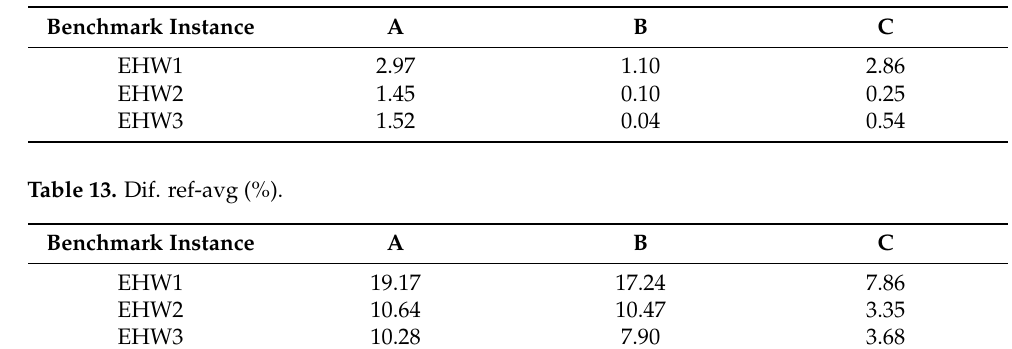
Table 12. Dif. ref-min (%).